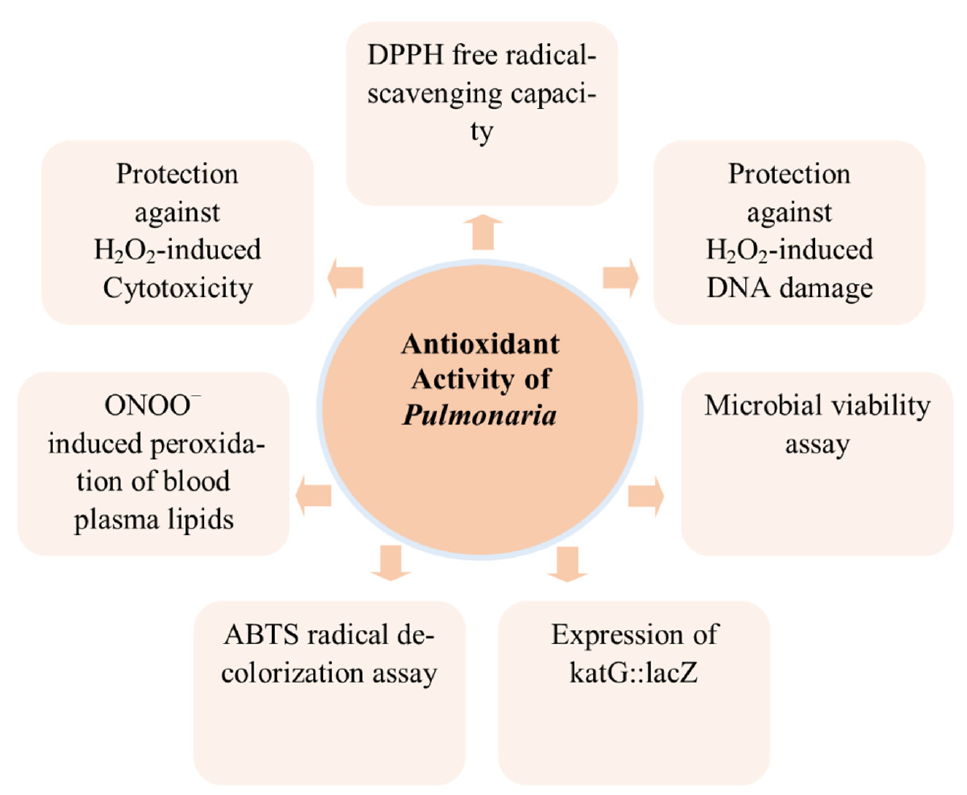
Figure 2. Antioxidant activity of lungworts studied through different methods.